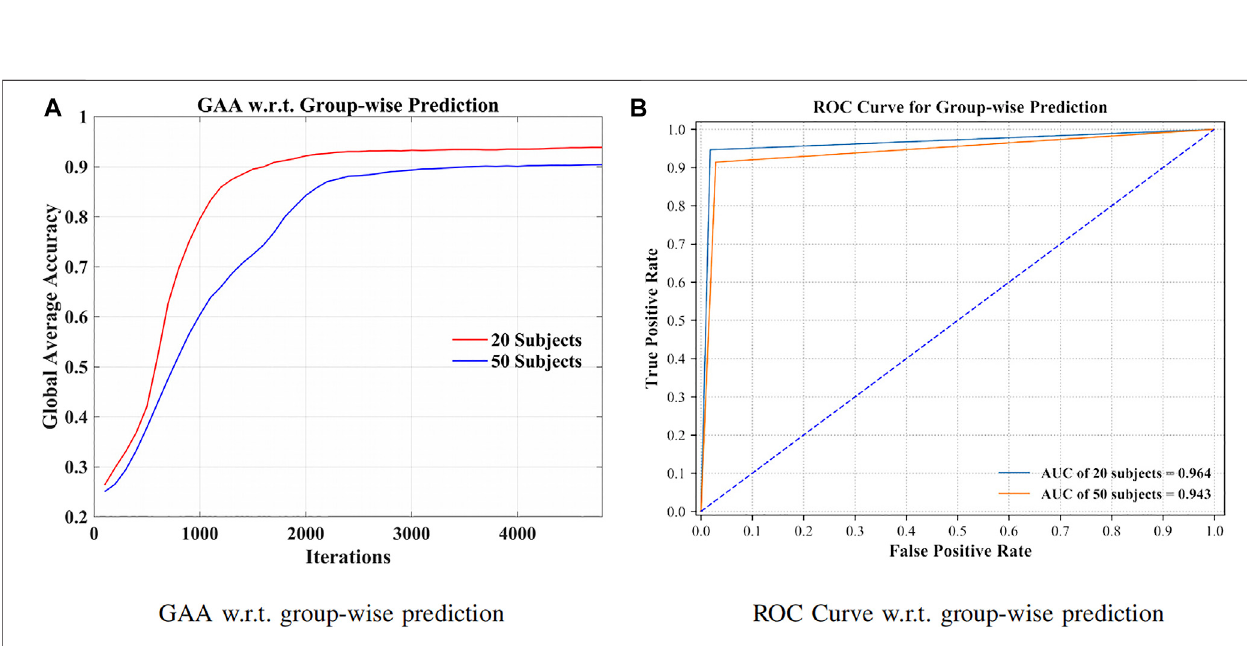
Frontiers in Bioengineering and Biotechnology |